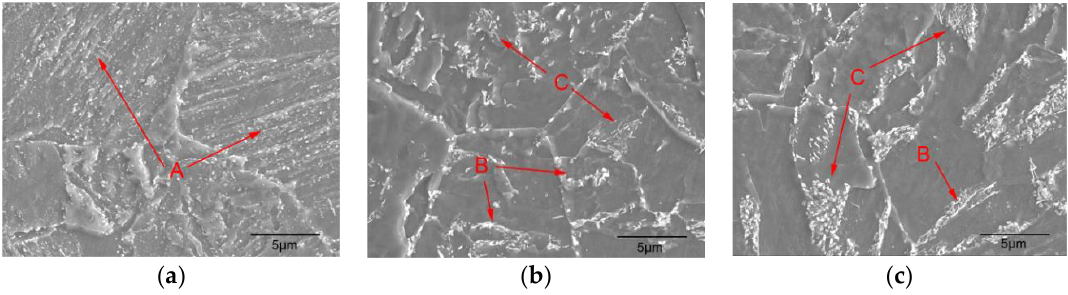
Figure 2. Scanning electronic microscope (SEM) microstructural images of 130 mm-thick steel plate. ( a ) 0 t; ( b ) 1/4 t; ( c ) 1/2 t. A denotes carbides precipitating on lath boundaries; B and C denote lath-like and blocky colonies of carbides respectively.